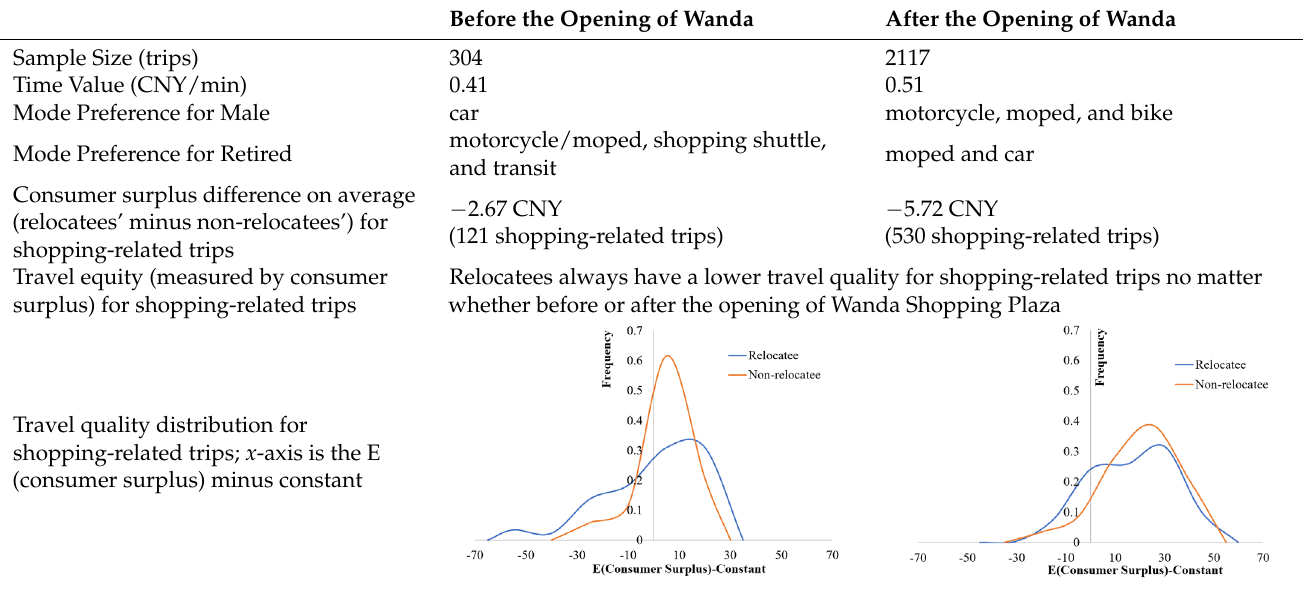
Table 3. Comparison of Time Value, Mode Preference, and Travel Equity Before and After the Opening of Wanda.